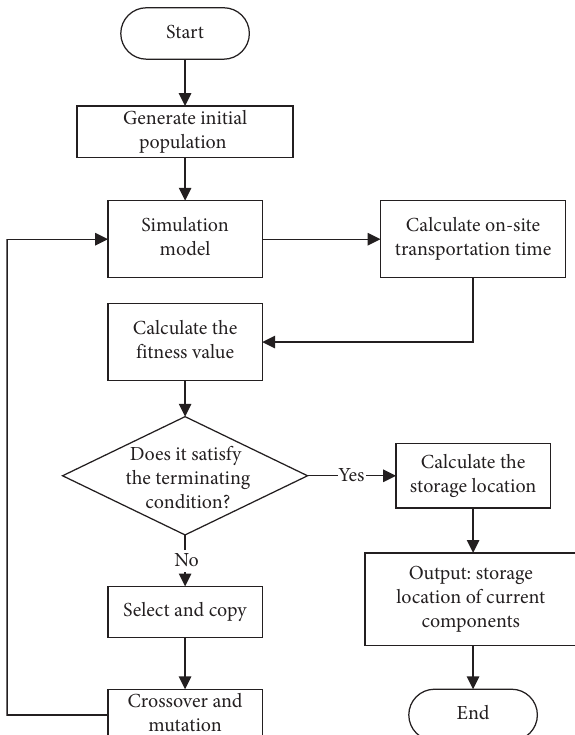
Figure 5: Flowchart of the solving process of the storage optimization